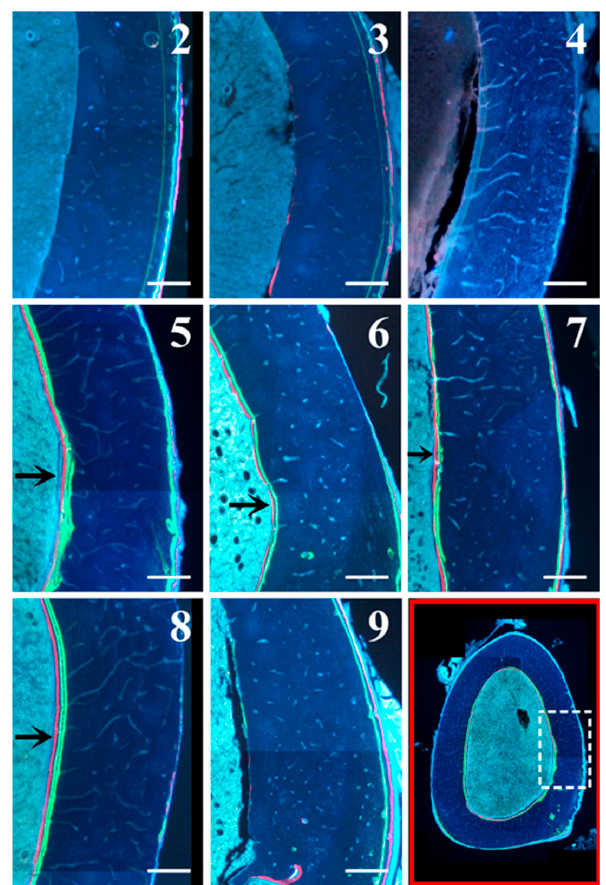
Figure 7. Details of femoral mid-diaphysis transversal sections of all animal groups under fluorescence microscope. In the bottom right image (outlined in red, as an example) the white dashed rectangle indicates the femur diaphysis portion showed in all micrographs (2–9). Note the presence of endosteal labels (arrows) in normal diet restoration groups (from 5 to 8). Scale bar: 250 μ m.